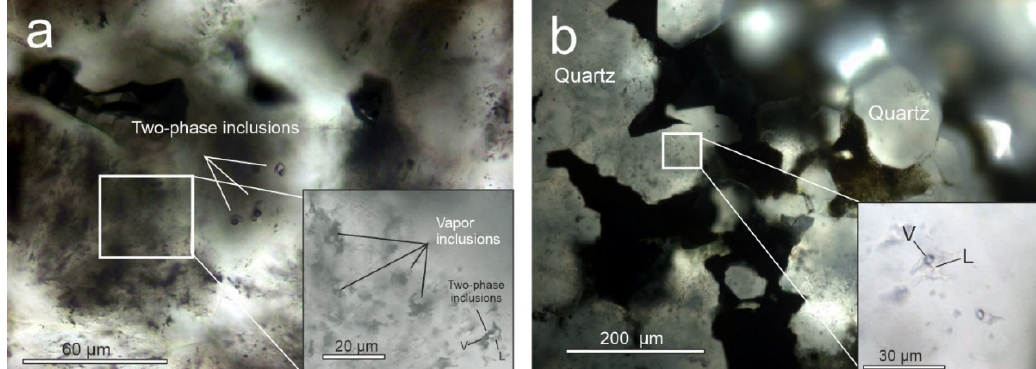
Figure 11. Microphotographs of quartz from the gold sulfosalt-quartz association: ( a )—two-phase inclusions of isometric shape in the center of a transparent quartz crystal (sample Bar-5_2/1). Gaseous and two-phase inclusions of irregular shape on the crystal growth zone are shown in the inset; ( b )—paragenesis of quartz, chalcopyrite and sulfosalts (dark) in a quartz vein (sample Bar-5_2/1). Primary two-phase fluid inclusions in a quartz crystal are shown in the inset. Table 7. Summary of the microthermometric study of fluid inclusions in quartz from the gold-sulfosalt-quartz association. Sample